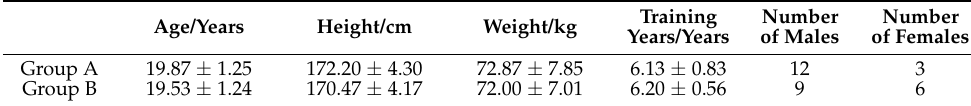
Table 1. Basic information of